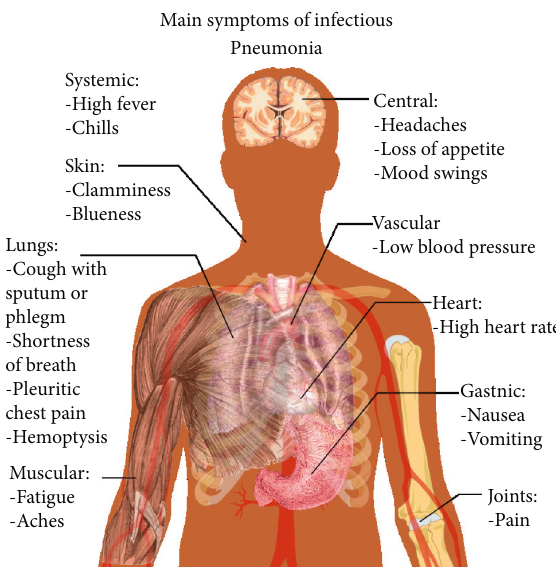
Figure 1: Basic indications of infectious pneumonia.